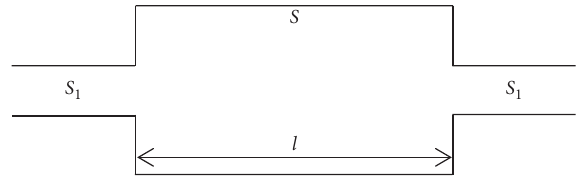
Figure 1: Diagram of an expansion chamber